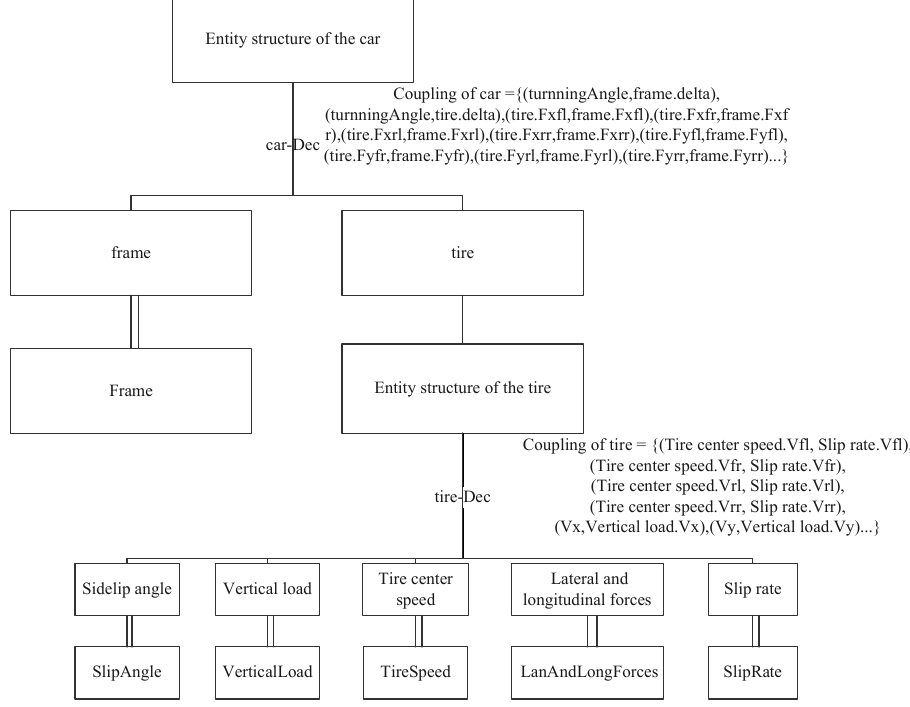
Figure 12. The SES-X of a car.